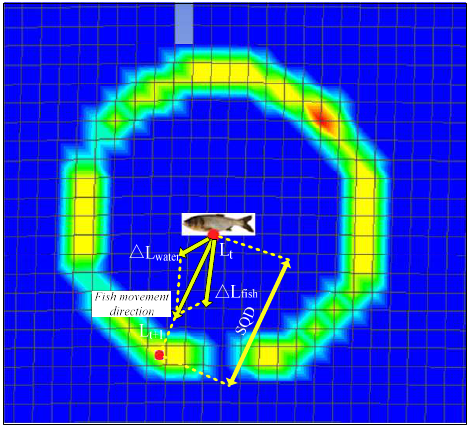
Figure 5. Illustration of fish movement rules of the model.